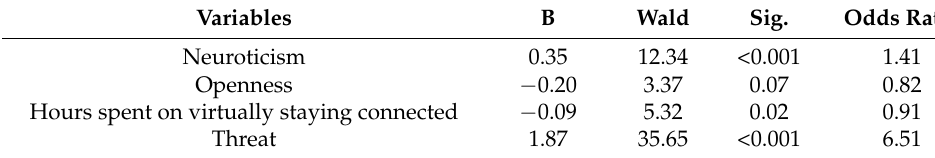
Table 4. Significant predictors for the feeling about the future variable ( n = 392). Variables B Wald Sig. Odds Ratio